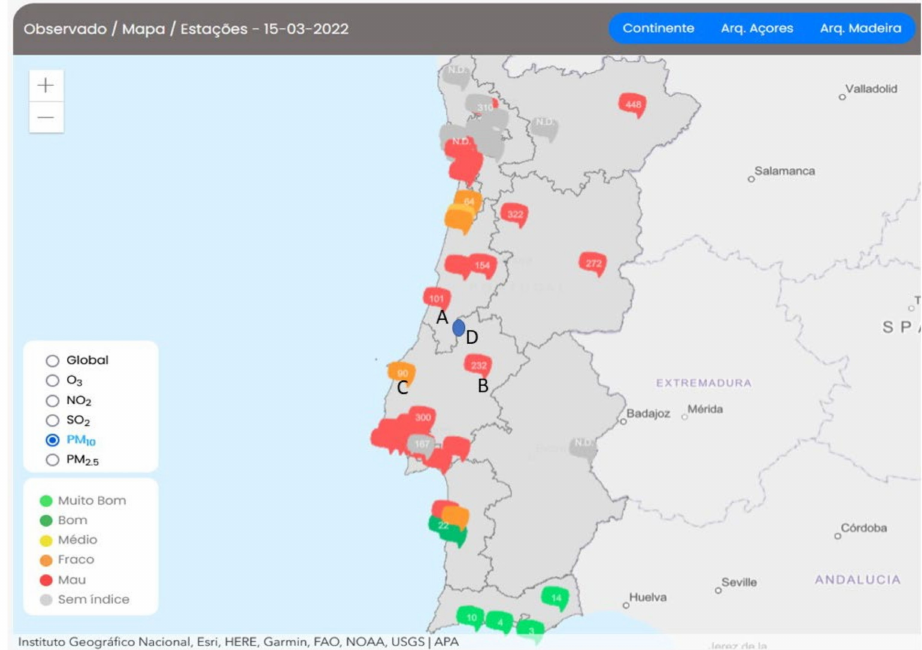
Figure 3. Map of Portugal showing the localization of outdoor air quality monitoring stations: A (Ervedeira), B (Chamusca), and C (Lourinh ã ) of the National Air Quality Monitoring Network, operated by the Portuguese Environment Agency (APA, Amadora, Portugal), and D (F á tima). Source: https://qualar.apambiente.pt (accessed on 23 June